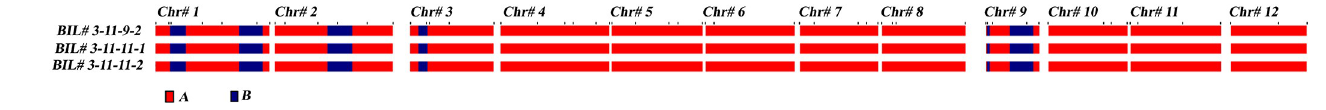
Fig 4. Graphical genotyping of 3 superior BILs showing the extent of IWP genome recovery.